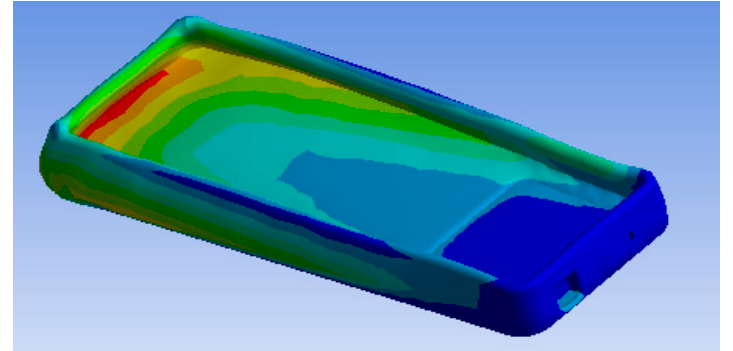
Figure 7. Ansys simulation result—deformation.